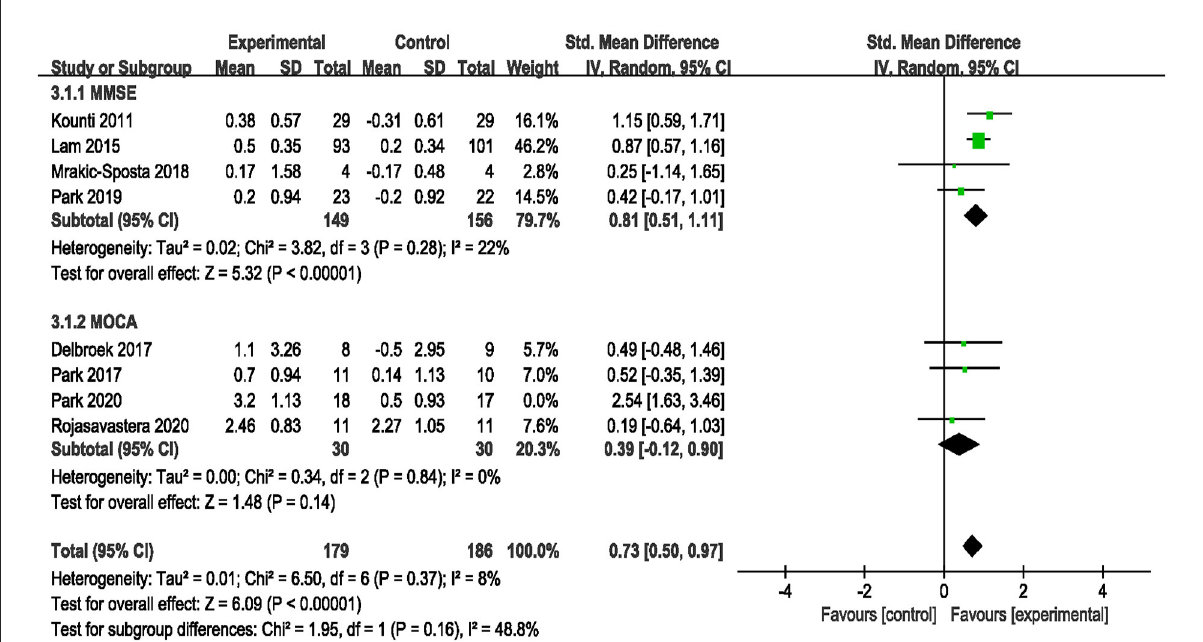
FIGURE5 Forest plot of the efficacy of the combined intervention on global cognition in older adults with MCI compared to the control group (sensitive